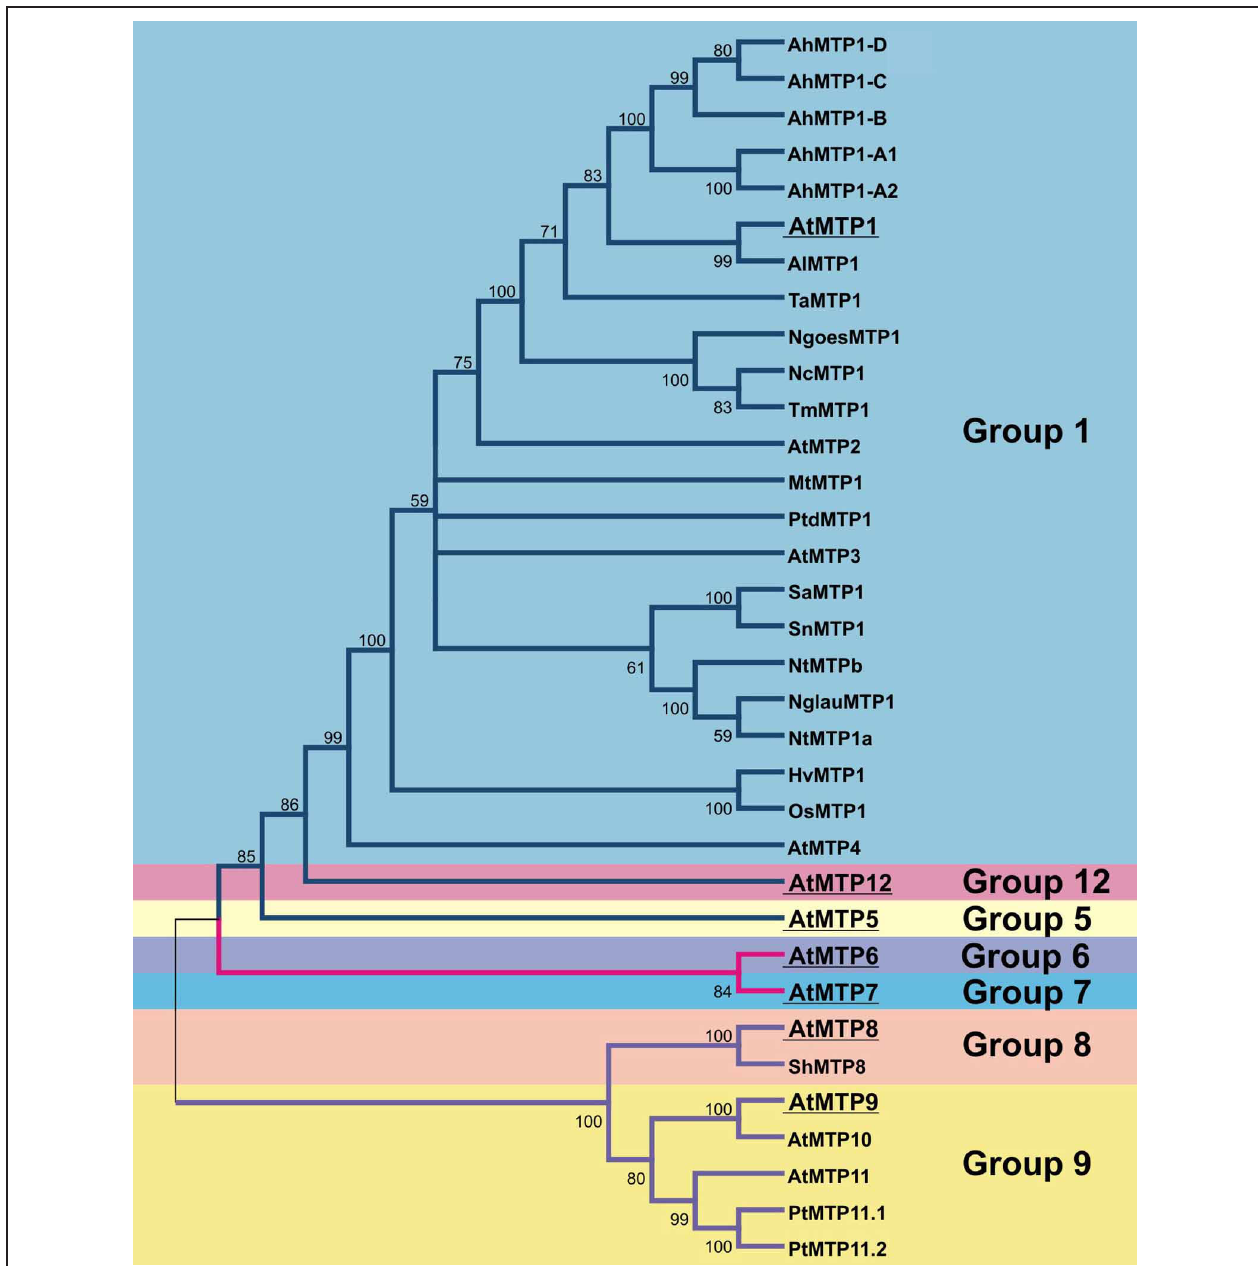
FIGURE 1 | Guide tree showing the phylogenetic groups of MTP proteins in plants. The tree was constructed using all sequences cited in Table 1 plus all MTP proteins from A. thaliana , as each group of MTP was named after its first A. thaliana member. Founding members of each group are highlighted. Colors of branches are in blue for Zn-CDF group proteins; pink for Fe/Zn-CDF proteins; and purple for Mn-CDF